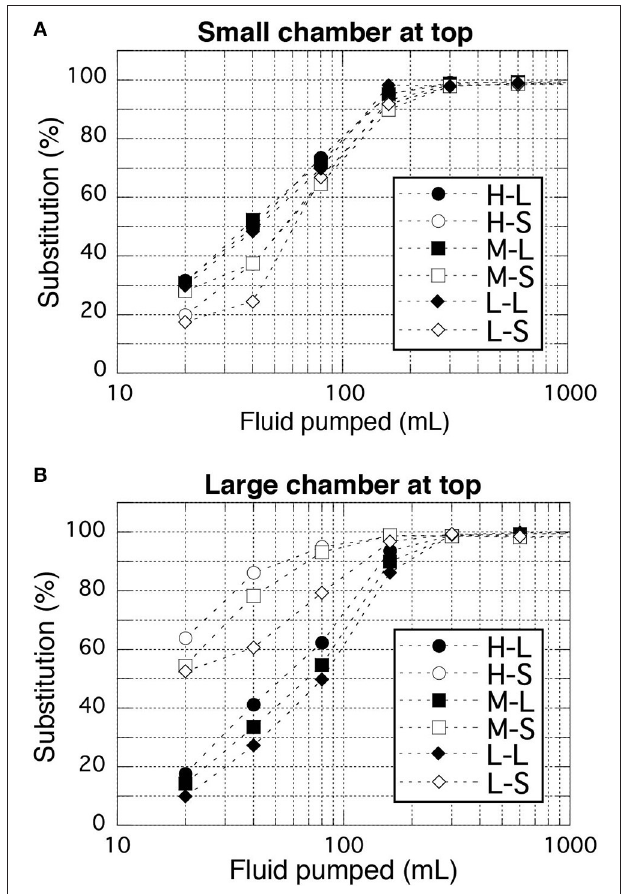
FIGURE 4 | Results of fluid substitution examinations. (A,B) Represent the smaller chamber of a bottle at top and bottom, respectively. Two-characters labels shown in the legend represent a combination of pump speeds (High, Mid, Low) and analyzed chambers (Large and Small). Analytical errors ( < 2%) are comparable to the size of the